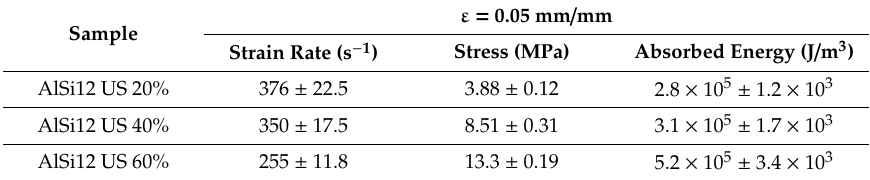
Table 5. Results for the AlSi12 foams and US and the di ff erent nominal relative densities.